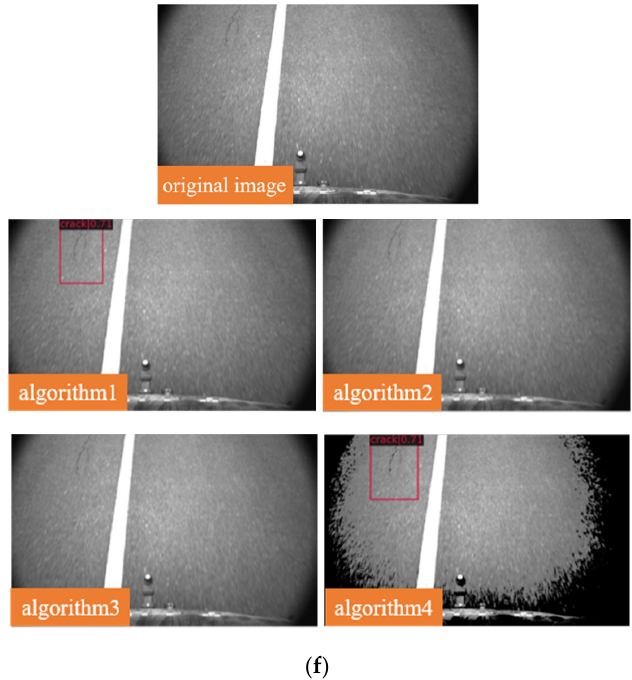
Figure 9. Testing results. ( a ) Results for testing data image1 with different methods. ( b ) Results for testing data image2 with different methods. ( c ) Results for testing data image3 with different methods. ( d ) Results for testing data image4 with different methods. ( e ) Results for testing data image5 with different methods. ( f ) Results for testing data image6 with different methods.